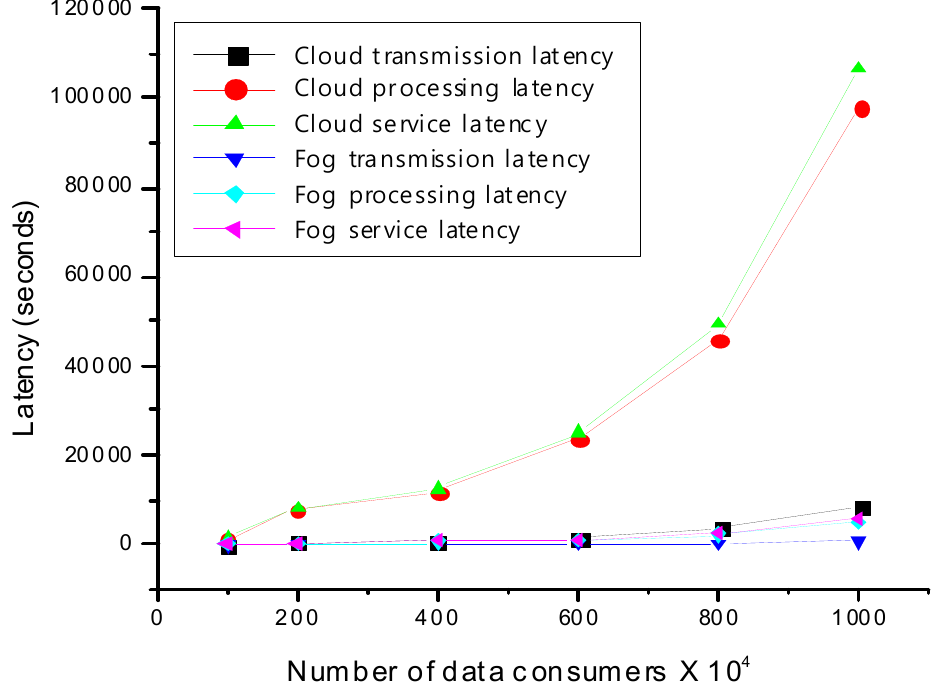
Figure 5. Comparison of latencies in fog and generic cloud computing models .